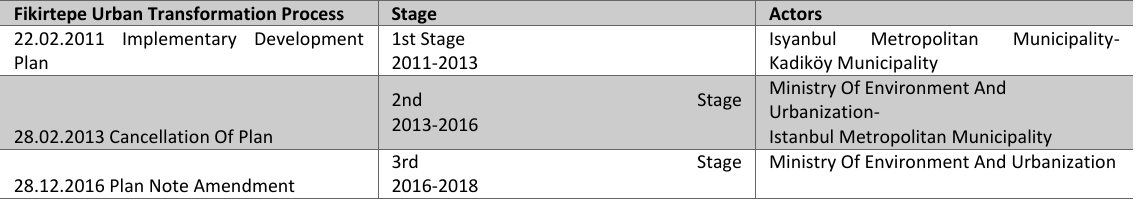
Table 1: Fikirtepe Urban Transformation Process Fikirtepe Urban Transformation Process Stage